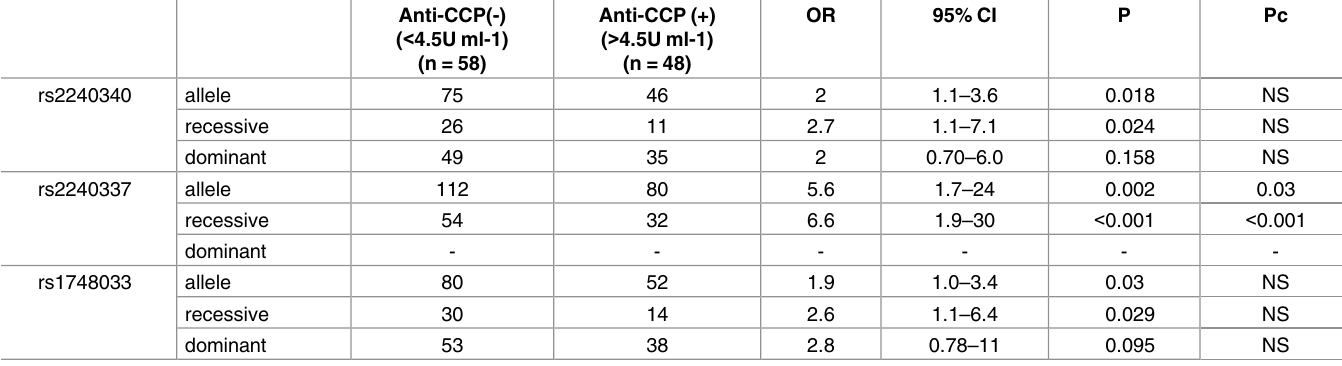
Table 4. Association between PADI4 gene polymorphisms and ACPA positivity in oligo- and poly- articular JIA patients (n = 106).